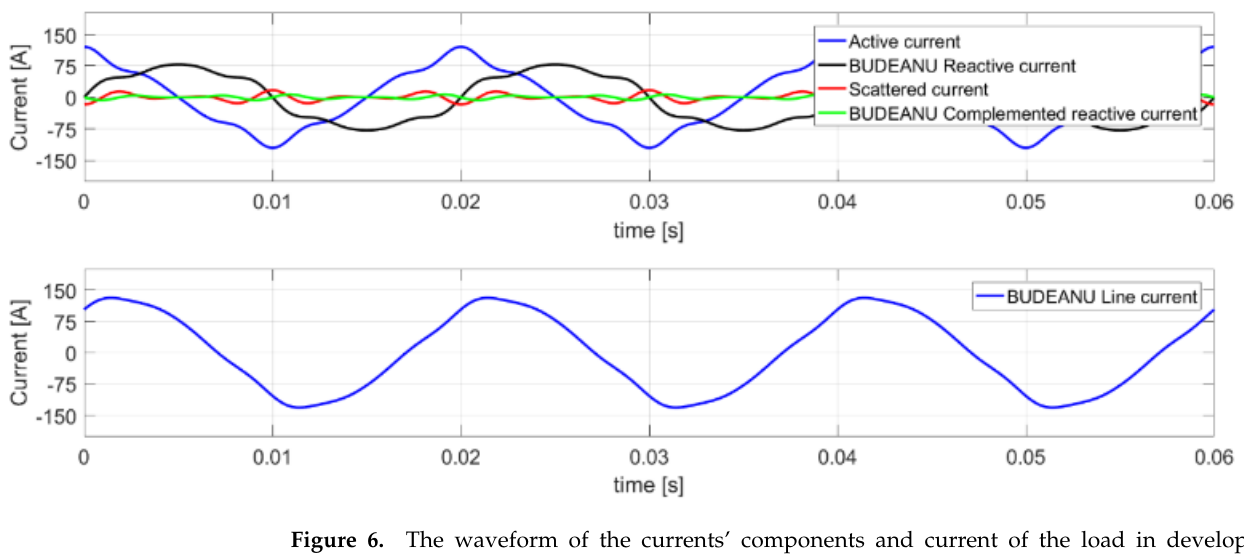
Figure 5. The waveform of the currents’ components and current of the load in CPC theory.